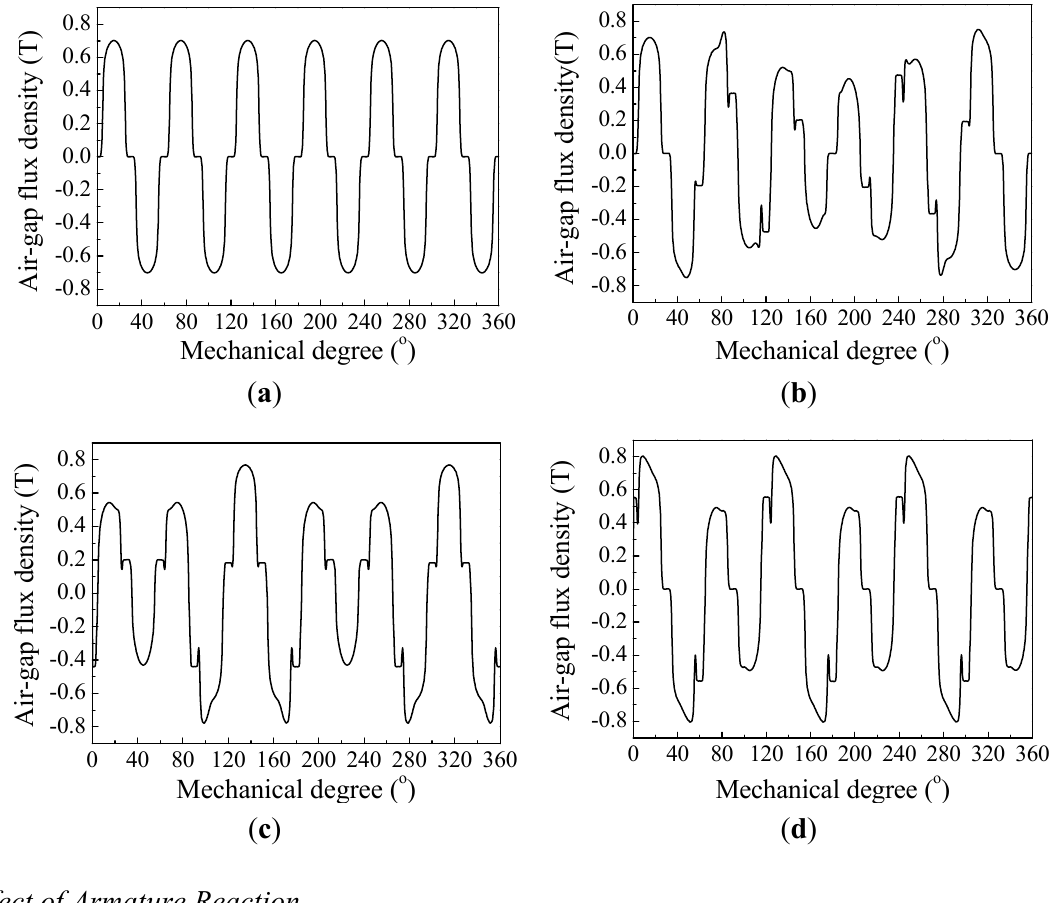
Figure 4. Waveforms of the SM air-gap flux density when the DRM and SM have different matches of poles. ( a ) DRM: 12 poles, SM: 12 poles; ( b ) DRM: 10 poles, SM: 12 poles; ( c ) DRM: 8 poles, SM: 12 poles; ( d ) DRM: 6 poles, SM: 12